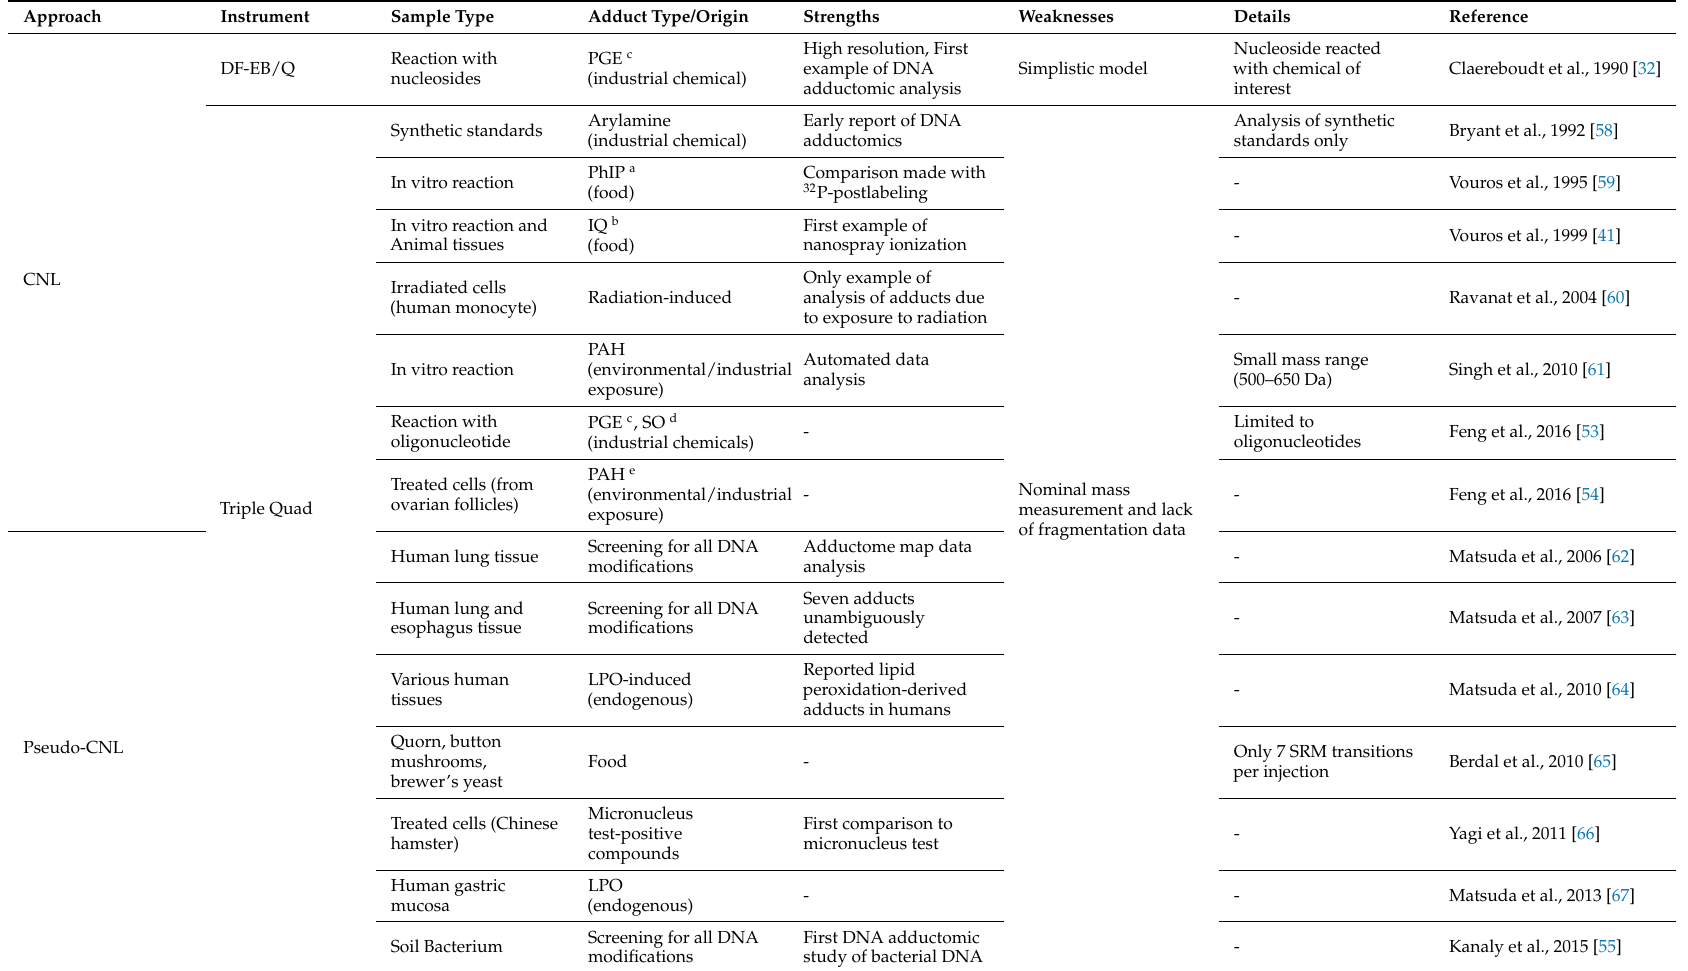
Table 2. Summary of published LC-MS-based DNA adductomics